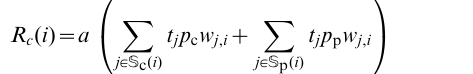
codons of amino acid asparagine (N). In the case of asparagine, the codon with a higher R c has a higher e M as it also has a much higher R n . The regression line between observed R c and R n in E. coli is represented as a solid red line. The positive correlation between R c and R n , explains why codons with higher R c sometimes have a higher missense error rate. Figure S3 The distribution of correlation coefficients between a focal tRNA’s abundance t F and the abundance of its neighbors t N , r t . Open bars represents the null distribution of r t when tRNAs are randomly distributed across the genetic code, taking into account stereochemical constraints on possible tRNA anticodon types. Red bars represent the observed distribution of r t across all 73 prokaryotic genomes. The observed distribution is significantly different from the null distribution ( p , 0.001) across all three degenerate classes. Figure S4 The distribution of correlation coefficients between a focal tRNA’s abundance t F and the abundance of its neighbors t N , r r t . Open bars represents the null distribution of t when tRNAs are randomly distributed across the genetic code, taking into account stereochemical constraints on possible tRNA anticodon types as well as the observed amino acid frequency distribution in E. coli genome. Red bars represent the observed distribution of r t across all 73 prokaryotic genomes. The observed distribution is significantly different from the null distribution ( p , 0.001) across all three degenerate classes. Figure S5 Correlation of translation error rates e with cognate elongation rate R c using empirical estimate of tRNA abundances. We find that rates of both (a.) missense e M and (b.) nonsense errors e N are negatively correlated with the rate of elongation by cognate tRNAs at that codon. The dashed line indicates the regression line between R c and e . These results are consistent with the results obtained using tRNA gene copy numbers as proxies for tRNA abundances. Table S1 List of genomes analyzed. Table S2 List of codon-specific tRNAs, elongation rates and error rates in E. coli .